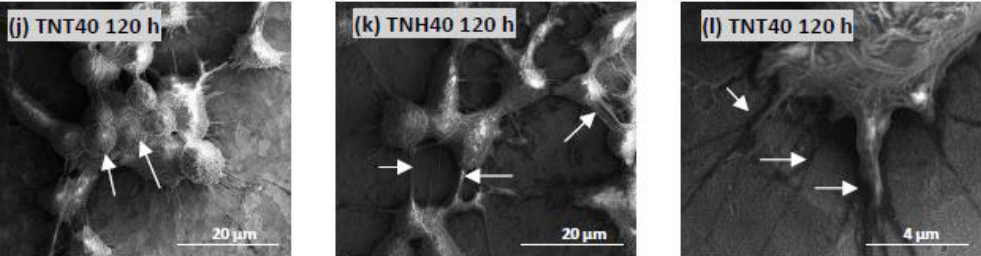
Figure 8. Scanning electron microscopy (SEM) images presenting proliferation of the murine L929 fibroblasts growing on the surface of the titanium alloy references sample (Ti6Al4V; ( a – c ) in comparison with Ti6Al4V/TNH40 sample; ( d – f ) and Ti6Al4V/TNT40 sample; ( g – i ). Arrows in the image ( j ) show the cells growing in layers on top of each other. Arrows in micrographs ( k ) and ( l ) indicate filopodia spread between cells or penetrating deep into the TNT40 nanolayers, respectively J. Clin. Med. 2019 , 8 , x FOR PEER REVIEW Importantly, as it can be seen in Figure 8(j), L929 fibroblasts also start to grow in layers on top of each other and this phenomenon is much more noticeable during the MG-63 osteoblasts incubation (see, e.g., Figure 9(j)), when the entire surface of TNH40 as well as TNT40 coatings is overgrown with multilayer structure of growing cells after 120 h of incubation time (Figure 9(f) and (i), respectively). Finally, SEM images show that L929 fibroblasts as well as MG-63 osteoblasts form numerous filopodia, which strongly attach the cells to the nanocoatings surface by penetrating deep into nanolayers (arrows in Figure 8(l) and Figure 9(l), respectively) or the cells generate filopodia between themselves (arrows in Figure 8(k) and Figure 9(k), respectively).